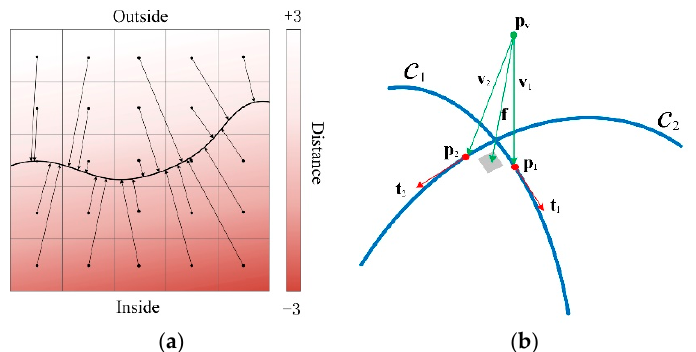
Figure 2. Schematic of truncated signed distance field (TSDF) constructed from intersecting curves; ( a ) a 2D slice of the TSDF computed on a regular voxel grid; each arrow indicates the distance vector of a voxel; gradients of color encode the signs and values of the distances; ( b ) a simple example of computing the value f of a vector